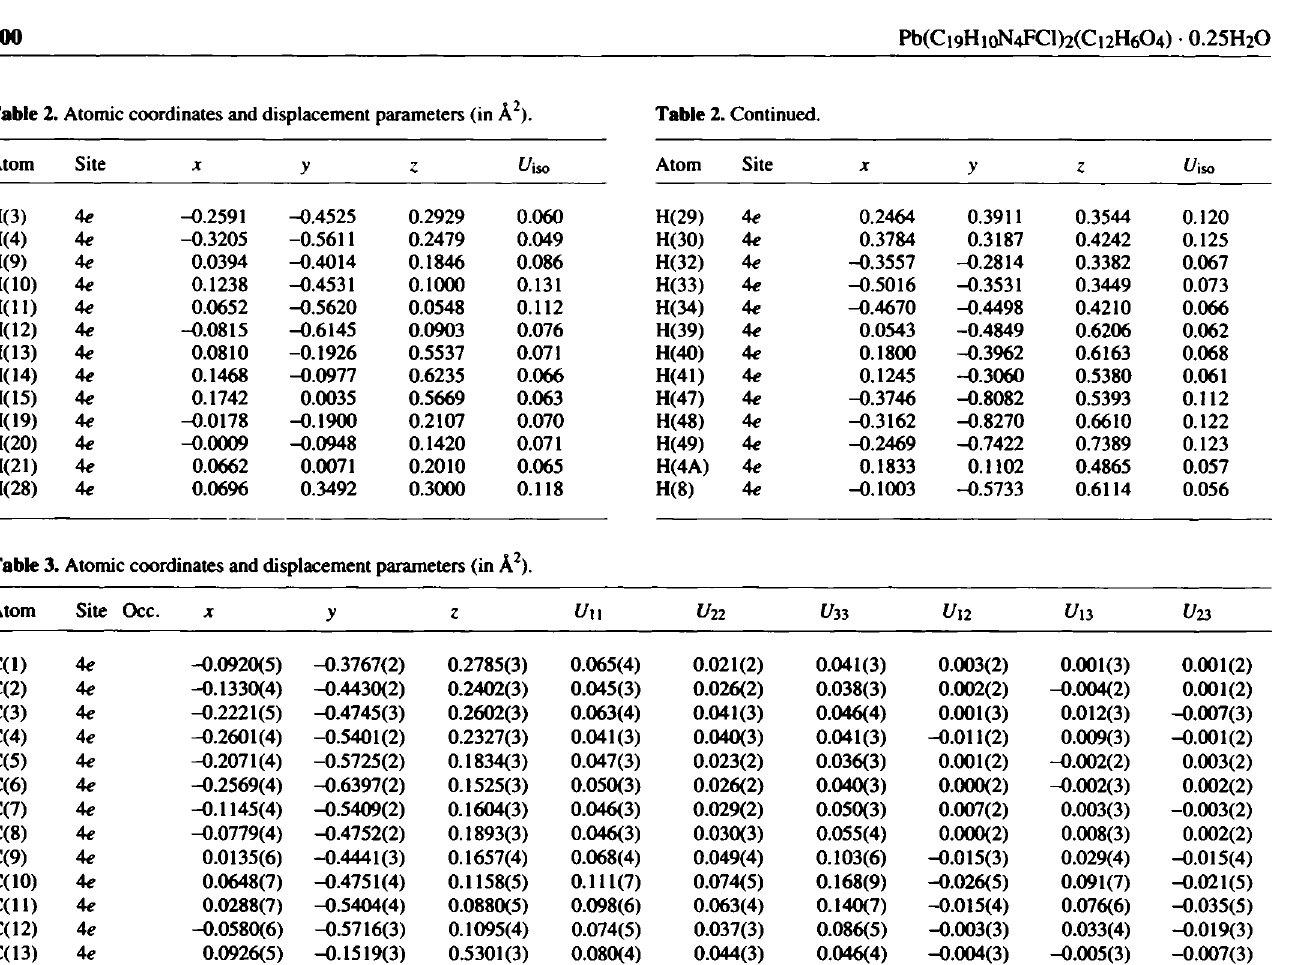
Table 3. Atomic coordinates and displacement parameters (in À 2